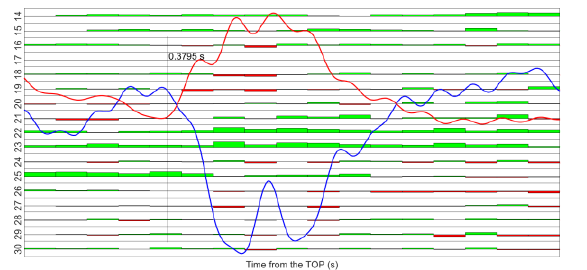
Fig. 8. Variation of signals measured by the device instrumentation (flowmeters) and S/B ratio evolution obtained with the hodoscope detectors for the upper part of the fuel rod, for a time range [t0+375ms; t0+392 ms].